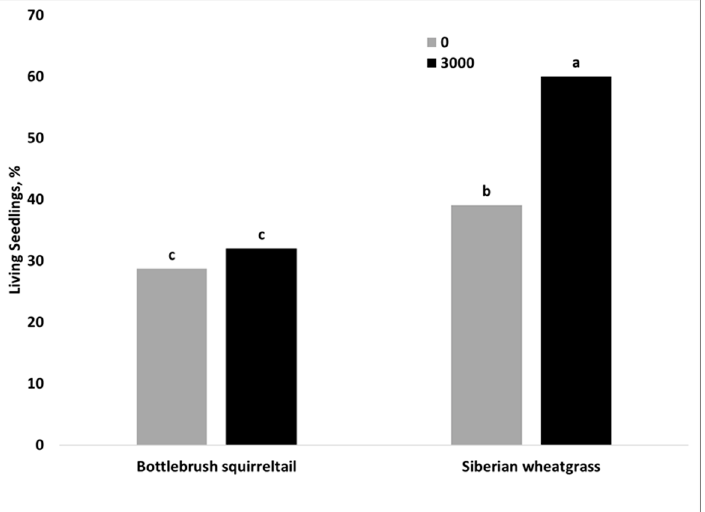
Figure 6. Percentage of live seedlings ( p < 0.0001) as a function of a superabsorbent polymer (SAP) application averaged across 56 d of a glasshouse study and seeding rates of 2, 4, 8, or 16 kg ha − 1 for bottlebrush squirreltail and Siberian wheatgrass. The SAP rate of 3000 kg ha − 1 was placed in a band at a depth of 8 cm directly below the seed. Following SAP treatment, the soil was saturated once and then dried down naturally over the time of the study. Bars that share the same letter are not statistically different from each other.